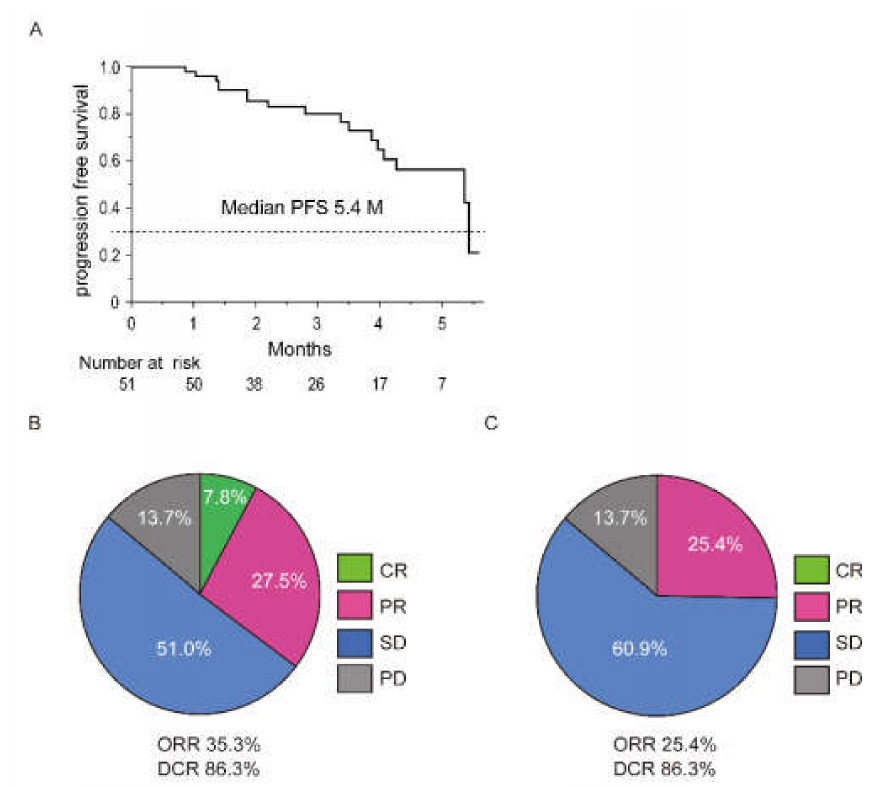
Figure 2. PFS and therapeutic response of atezolizumab plus bevacizumab. ( A ) PFS curve of the patients treated with atezolizumab plus bevacizumab. The median PFS was 5.4 months. ( B ) Assess- ment of the therapeutic response using modified RECIST. ( C ) Assessment of the therapeutic response using RECIST. Abbreviations: PFS, progression free